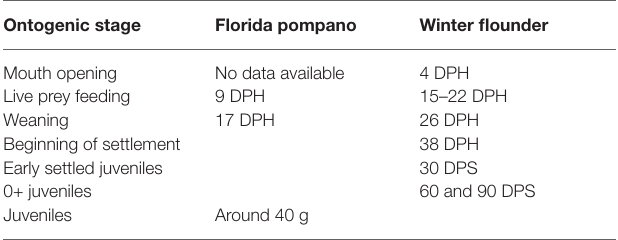
TABLE 2 | Relative percentages of fatty acids in Florida pompano ( T. carolinus ) larvae at live prey feeding and weaning (9 and 17 DPH, respectively; Cavalin and Weirich, 2009; Hauville et al., 2014).